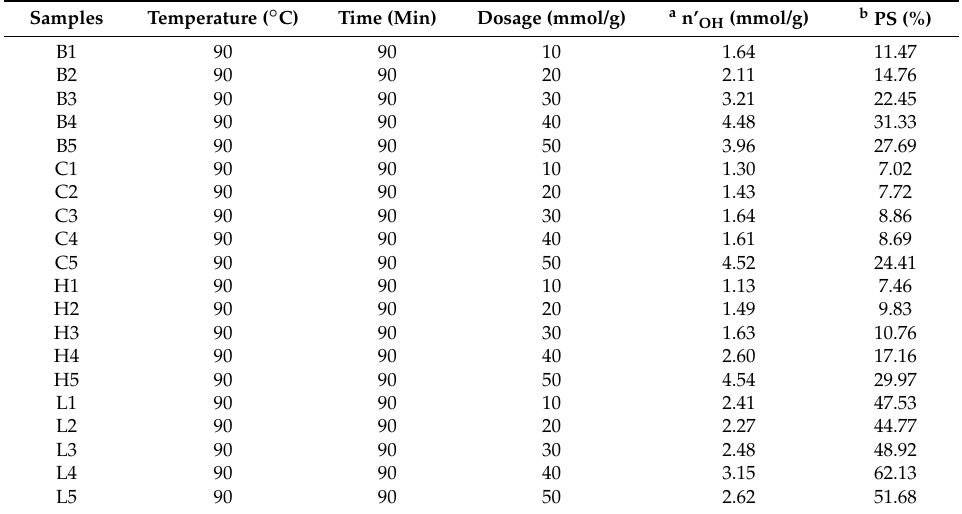
Table 1. The substituted hydroxyl content and the percentage of substitution of samples.